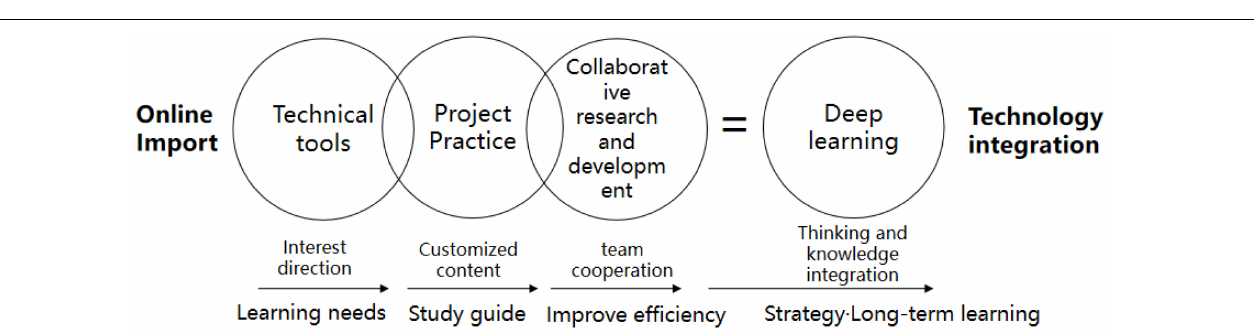
FIGURE 1 | New strategies for designing education under the background of artificial intelligence technology.